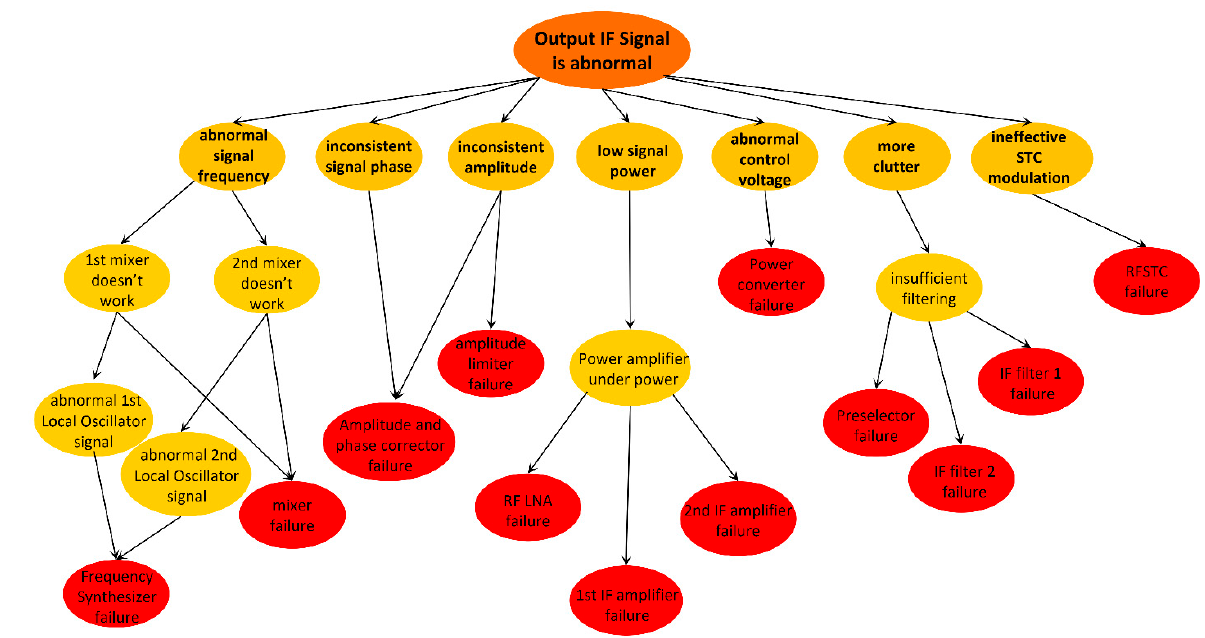
Figure 4. Relationship between abnormal IF signal fault phenomenon and fault